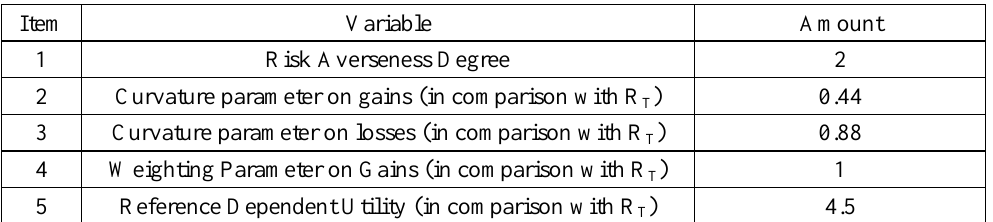
Table 2. Numerical Assumptions In Portfolio Risk And Performance